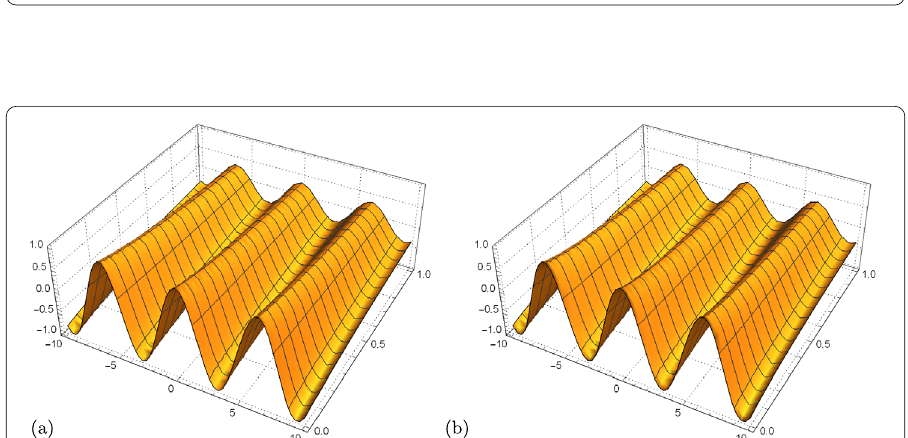
Figure 3 Residual error for Example 2 using 20th-order of approximation with α = 0.9 and β = 0.8. (a) for resdual error of u ( x , t ) and (b) for resdual error of v ( x , t )